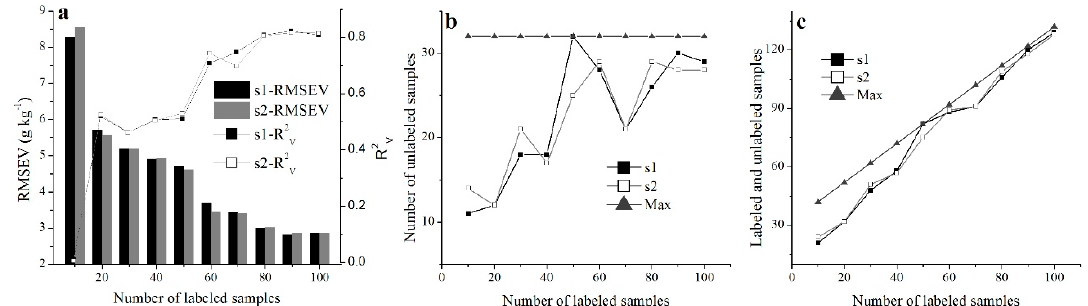
Figure 10. The performance of the two refined models of Co-LSSVMR ( a ); the number of unlabeled samples used in each refined model ( b ); and the total number of labeled and unlabeled samples used in each refined model ( c ) versus the number of labeled samples with 64 unlabeled samples available for exploitation. The “Max” in ( b ) indicates the maximum number of unlabeled samples available, which is 32, for each regressor; and the “Max” in ( c ) indicates the maximum total number of labeled and unlabeled samples available for each regressor.